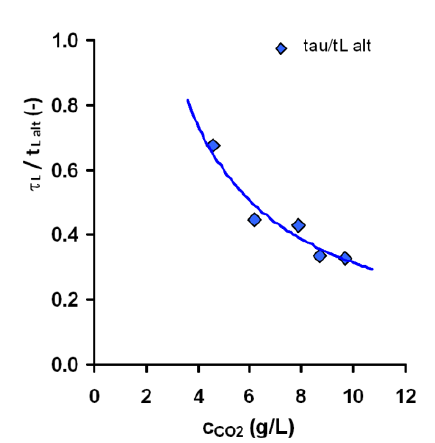
Fig. 13. Liquid formation – effect of CO 2 content:  L / t L alt ratio .